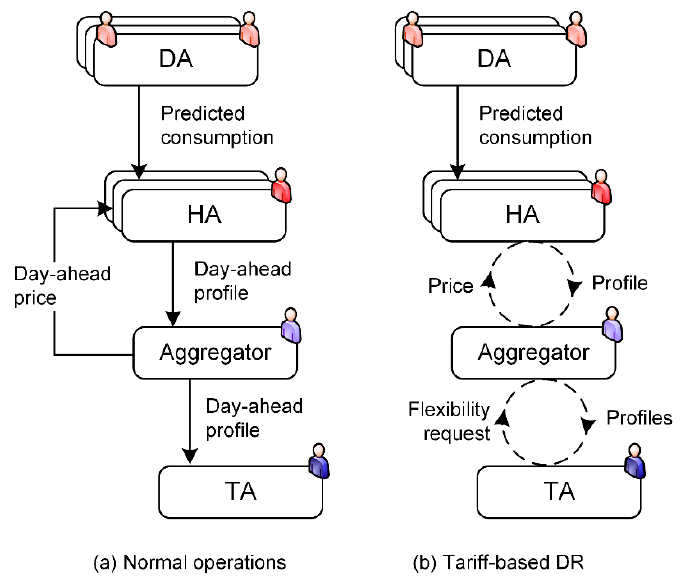
Figure 2. Interaction among the involved agents.